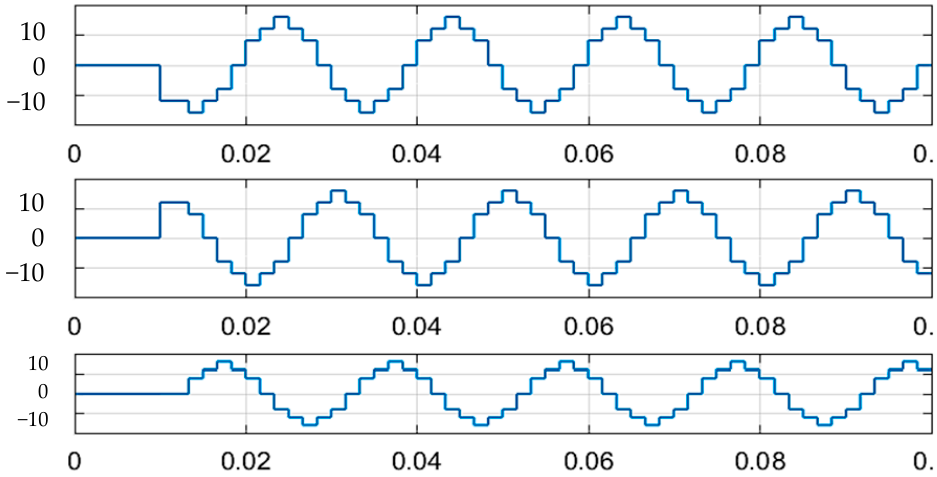
Figure 11. Phase voltage waveform at 150° [41].